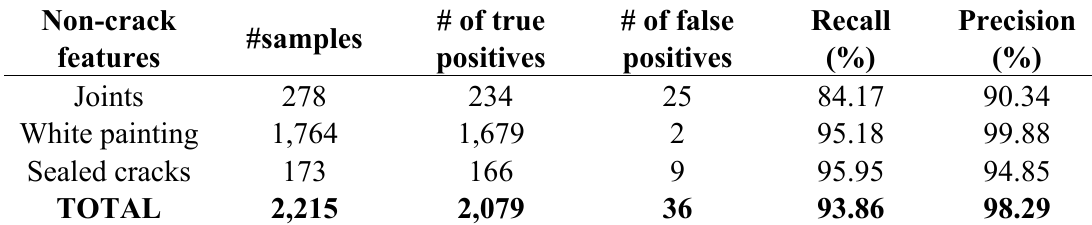
Table 2. Non-crack feature detection results.